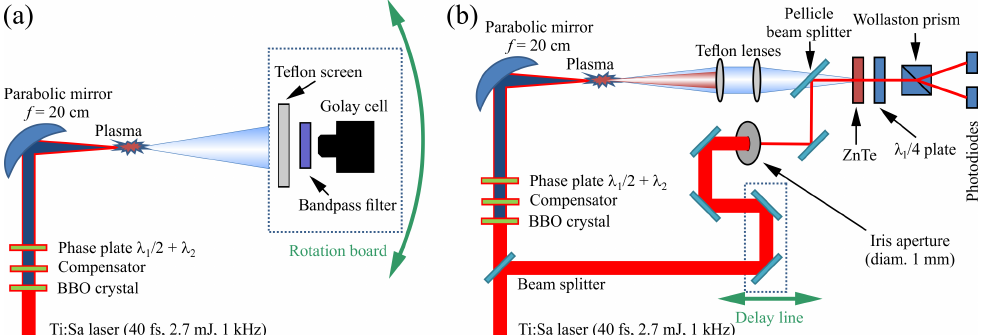
Figure 1. Experimental schemes. ( a ) Angular distribution measurements. Golay cell with a bandpass filter and teflon screen is mounted on the board rotating around the geometrical focus along the green arc with arrows on both sides. ( b ) Time-domain measurements. A focused THz beam is combined on the ZnTe crystal with a probe pulse, the time delay of which is varied by moving the delay line along the green line with arrows on both